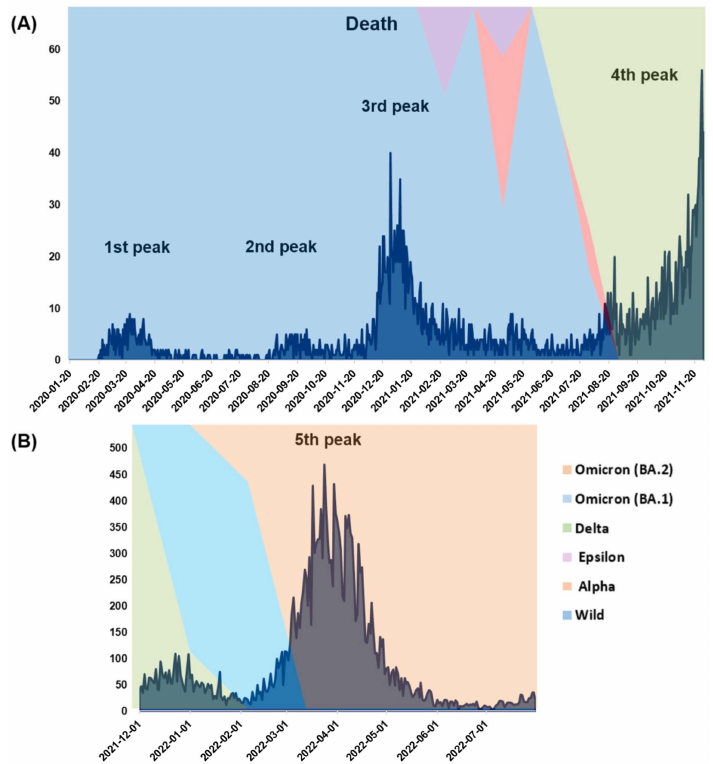
Figure 2. Distribution of deaths related to SARS-CoV-2 with peaks corresponding to the incidence peaks in South Korea ( A ) from January 2020 to November 2021 and ( B ) from December 2021 to July 2022. Data from the Korean Center for Disease Control (https://ncov.kdca.go.kr/, accessed on 2 January 2023).